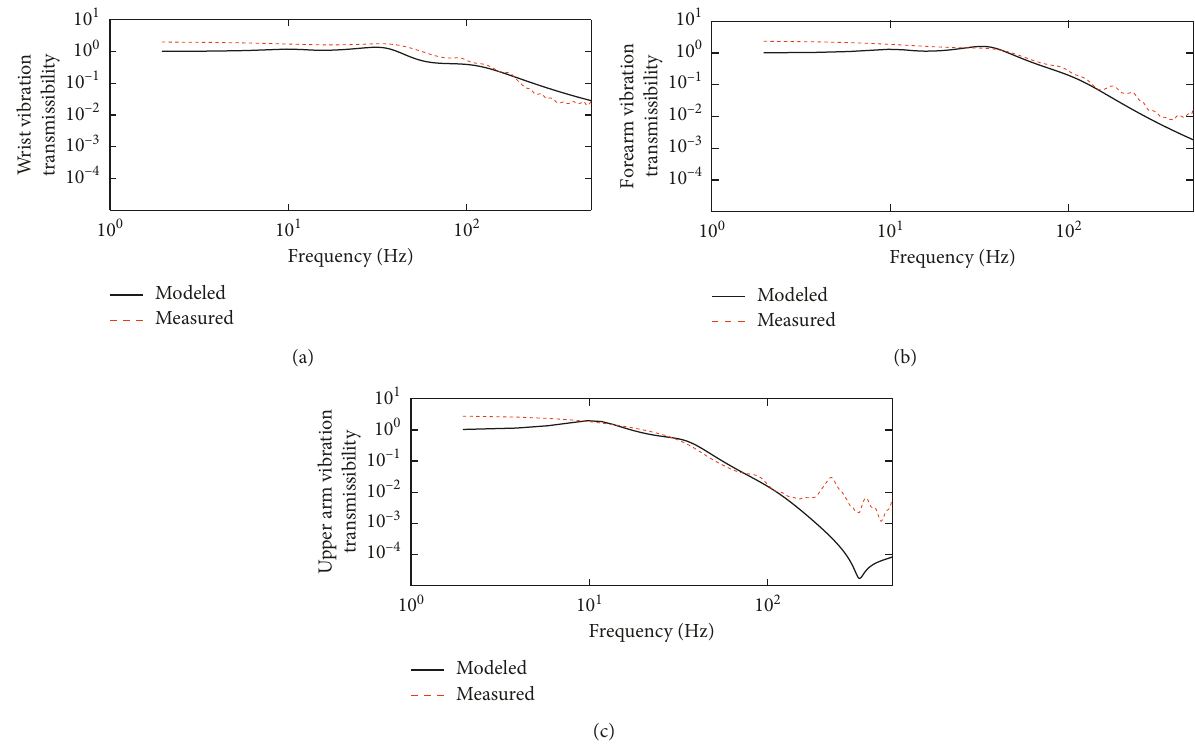
Figure 4: The VT for different sets: (a) wrist, (b) forearm, and (c) upper arm.